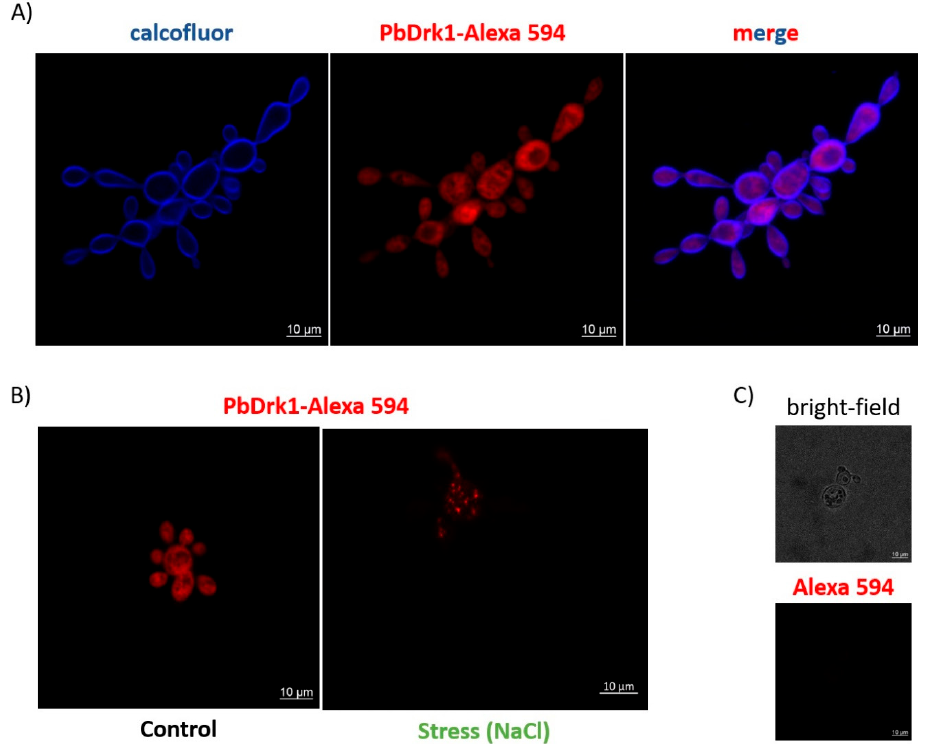
Figure 3. PbDrk1 localization and altered pattern of expression in osmotic stress condition. ( A ) Confocal microscopy of yeast cells. In blue: calcofluor white staining of the cell wall. In red: reactivity with primary anti-PbDrk1 antibody and anti-rabbit IgG-Alexa 594. ( B ) Confocal analysis under stress condition (0.15 M NaCl) and ( C ) control with secondary antibody alone. Alexa 594: secondary antibody anti-rabbit IgG conjugated with Alexa 594 nm.